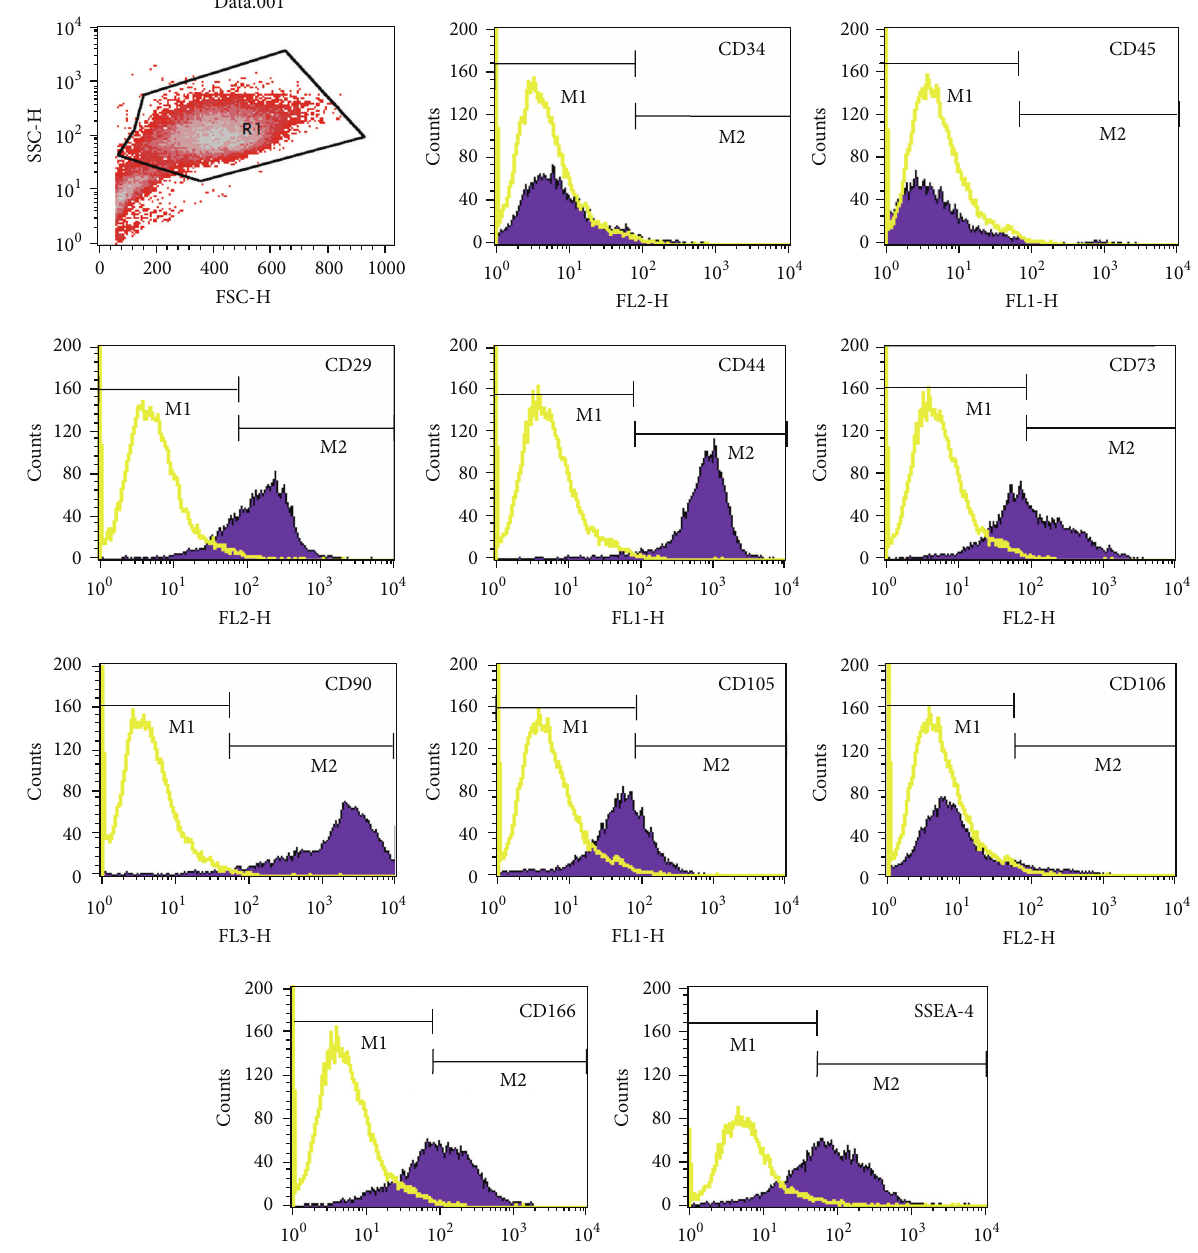
Figure 1: Phenotype of cells, at the third passage, isolated from human bone marrow of one donor. Antibodies listed in Supplementary Table 1 were used for this procedure. The figure shows representative histograms of multipotential mesenchymal stem cells obtained from FACS analysis. Black line signifies the specific antibody; yellow line represents the isotype